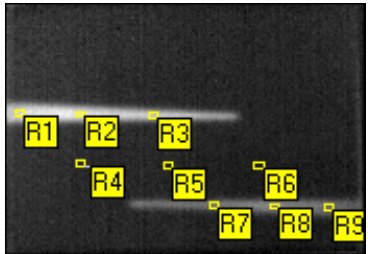
Figure 25. Schematic diagram of defect area and sound area sampling.